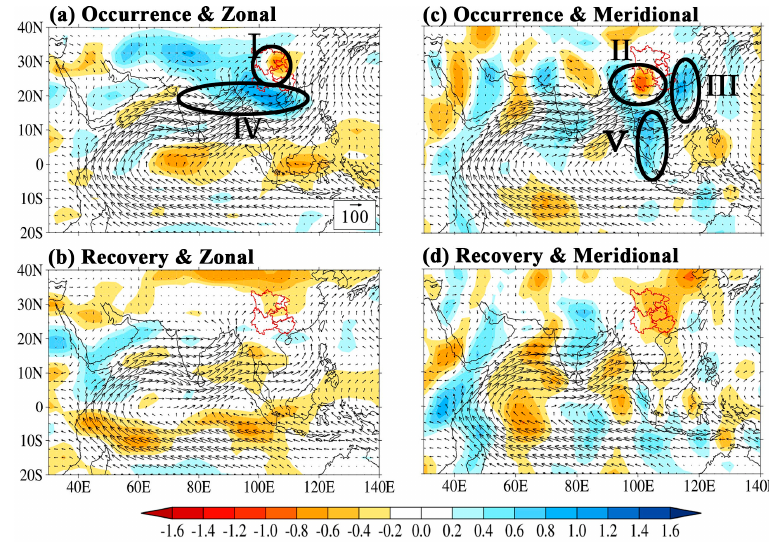
Figure 8. Composites of vertically integrated water vapor transport (WVT) and corresponding zonal standardized anomalies (SA) for wetter: ( a ) occurrence; and ( b ) recovery phases; and ( c , d ) the same as ( a , b ), respectively, but for meridional SA. Vectors represent WVT, whereas shadows represent SA. The unit of WVT is kg·m − 1 ·s − 1 . The northward and eastward directions of transport are positive. In addition to the geographical WVT anomalies, we studied the anomalous signals of the vertical cross-sections at different boundaries (Figure 9). In terms of wet occurrence, except for the 32.5° N boundary, anomalous features along 20.0° N, 97.5° E, and 110.0° E were distinguishable and showed sign reversal from those of drought occurrence. These anomalies matched well with Areas II, III, and V in Figure 8. For wet recovery, however, WVT anomalies at 20.0° N in the wetter process showed sign reversal from that of drought, whereas WVT anomalies at the other boundaries were implicit and scattered.